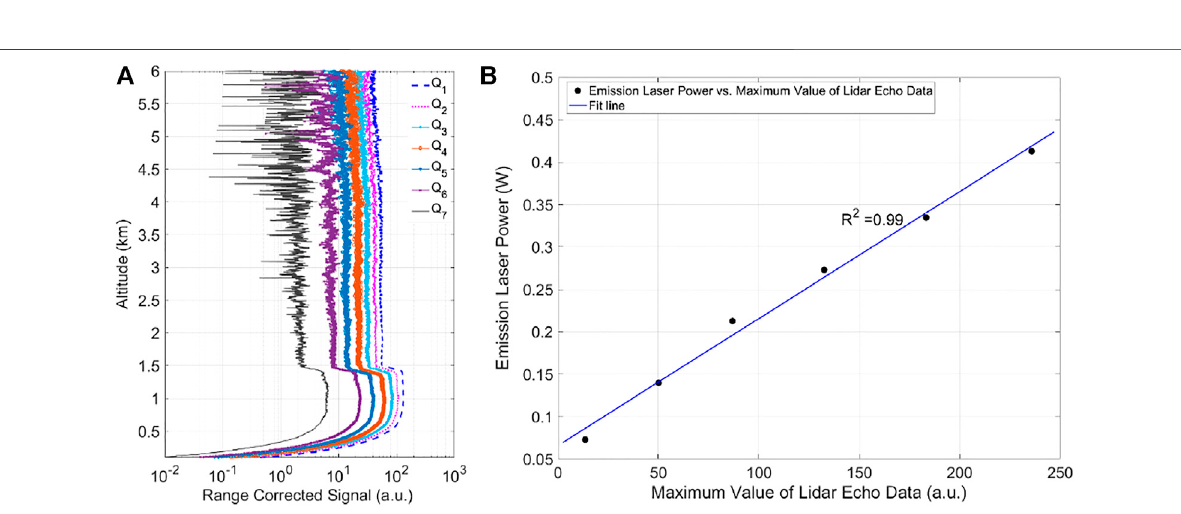
Frontiers in Physics |